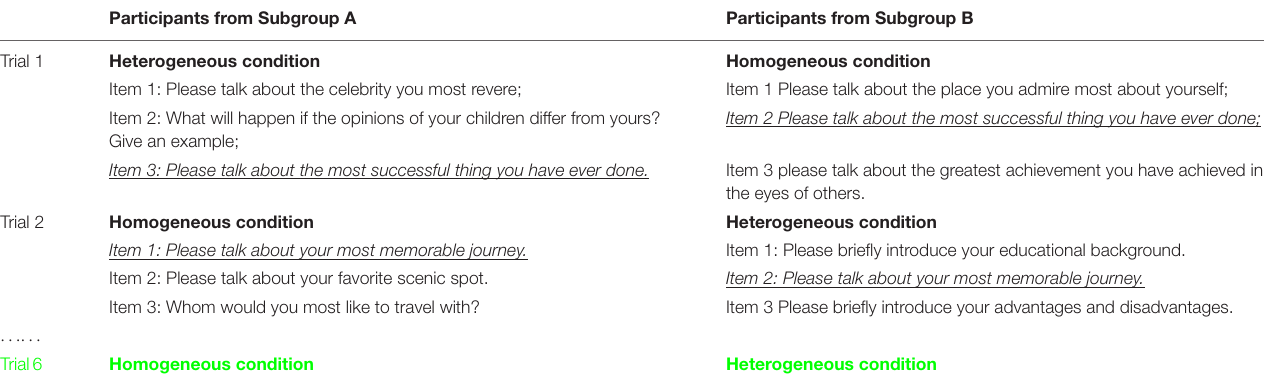
TABLE 3 | Between-item and within-subject design in experiment